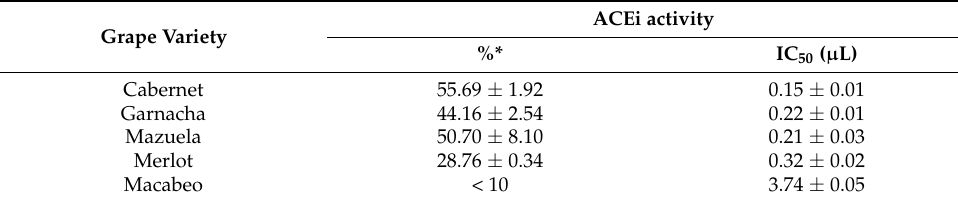
Table 1. Angiotensin-converting enzyme inhibitory (ACEi) activity of the wine lees obtained in the winemaking process using different individual grape varieties.